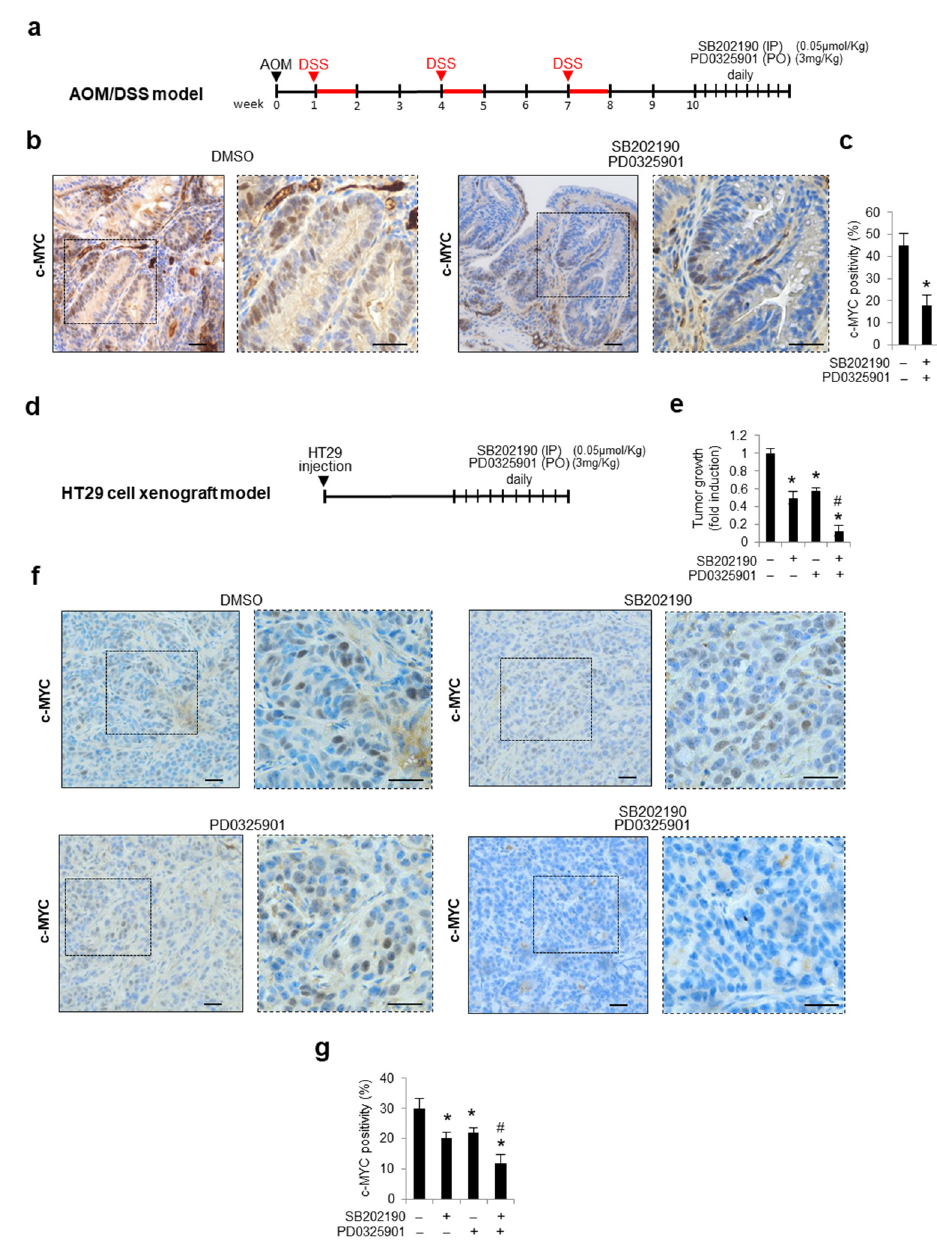
Figure 6. Combined inhibition of p38a and MEK affects c-MYC protein stability in preclinical mouse models. ( a ) Treatment scheme of AOM/DSS mice. ( b , c ) Immunohistochemistry analysis ( b ) and quantification ( c ) of c-MYC protein expression in colon tissue sections from AOM/DSS mice treated with DMSO or with SB202190 and PD0325901. ( d ) Treatment scheme of HT29-cell-xenograft mice. ( e ) Quantification of the volume of tumors explanted from HT29-xenografted mice treated with DMSO or with SB202190 and/or PD0325901. ( f ) Immunohistochemistry analysis of c-MYC protein expression in colon tissue sections from HT29-xenografted mice treated as above. ( g ) Quantification of c-MYC protein expression in colon tissue sections from HT29-xenografted mice treated as above. Magnification: 20×–40×. DMSO: dimethyl sulfoxide. Scale bar: 50 µm. IP: intraperitoneal injection. PO: oral administration. Statistical analysis was performed using Student’s t -test; * p < 0.05: vs. untreated cells, # p < 0.05: vs. corre- sponding single treatment. The presented results are representative of at least three independent experiments.